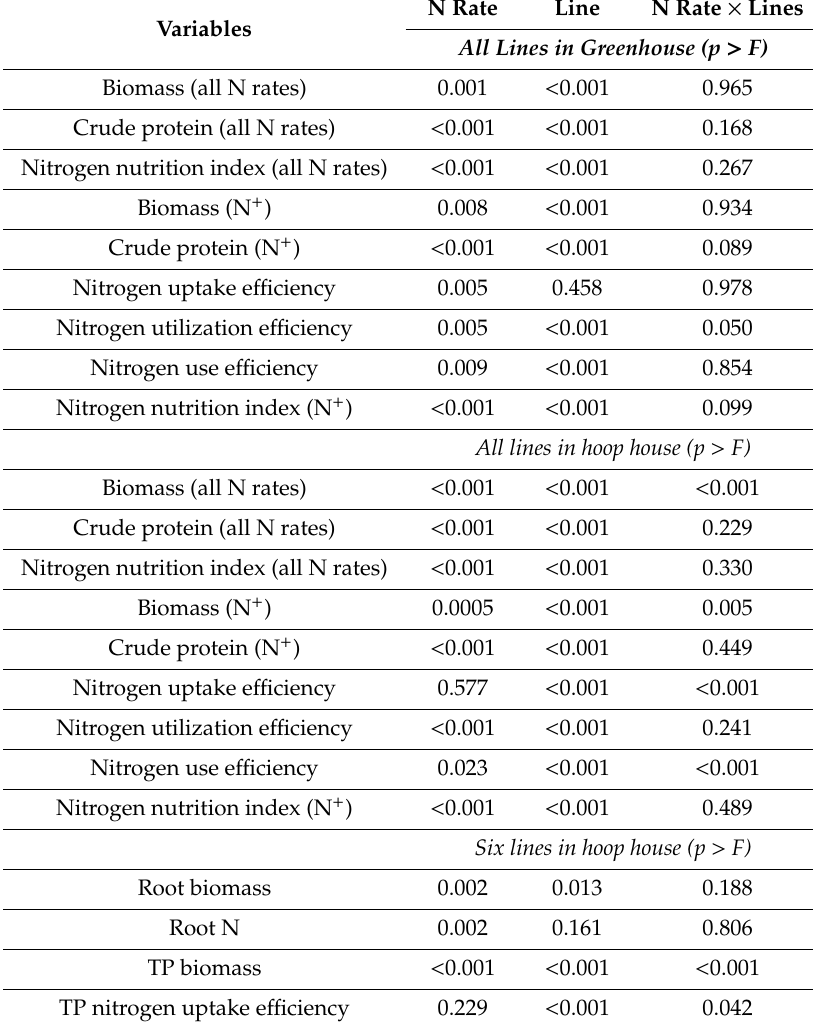
Table 1. F -test of fixed e ff ects for biomass, crude protein, nitrogen uptake e ffi ciency, nitrogen utilization e ffi ciency, and nitrogen use e ffi ciency in greenhouse and hoop house. F -test of fixed e ff ects for root biomass, root N, total plant biomass, and total plant nitrogen uptake e ffi ciency for six wheat lines grown in the hoop